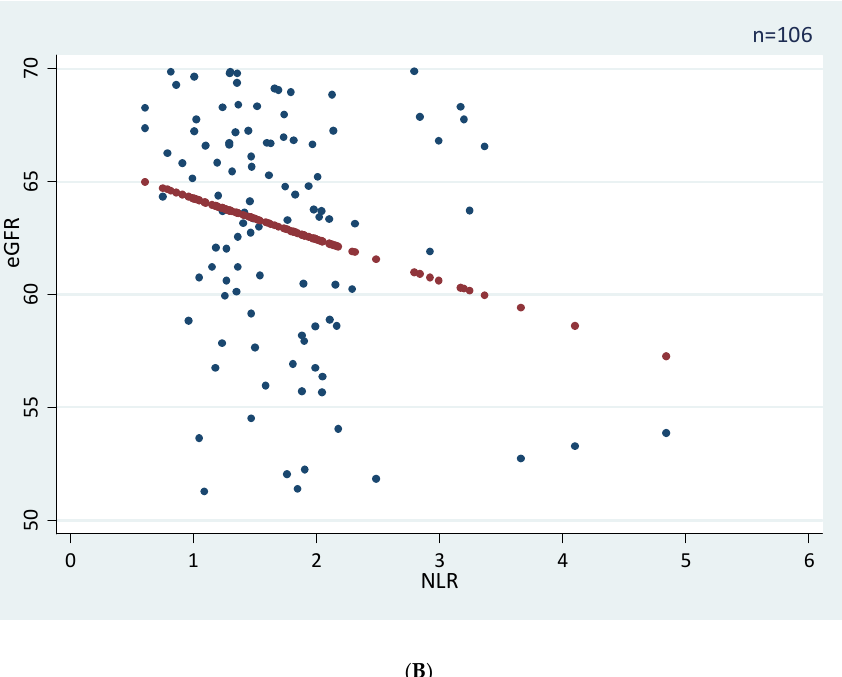
Figure 1. ( A ) Linear regression analysis of eGFR between 50 and 70 mL/min/1.73 m 2 against NLR in overweight/obese men with eGFR as the dependent variable. The mathematical equation was eGFR = 63.8 − 1.04xNLR with a slope of −1.04 (95% CI: −1.75 to −0.34; p = 0.004), indicating a mean eGFR decrease of 1.04 mL/min/1.73 m 2 per unit NLR increment. ( B ) Linear regression analysis of eGFR between 50 and 70 mL/min/1.73 m 2 against NLR in overweight/obese women with eGFR as the de- pendent variable. The mathematical equation was eGFR = 66.1 − 1.82xNLR with a slope of −1.82 (95% CI = −3.17 to −0.47; p = 0.009), indicating a mean eGFR decrease of 1.04 mL/min/1.73 m 2 per unit NLR increment. Table 5. Regression Analysis of eGFR (mL/min/1.73 m 2 ) against Neutrophil/Lymphocyte Ratio (NLR) Stratified by BMI Status in Men(A) and Women(B). A. Men 18.5 ≤ BMI < 24 ( n = 766) BMI ≥ 24 ( n = 1011)